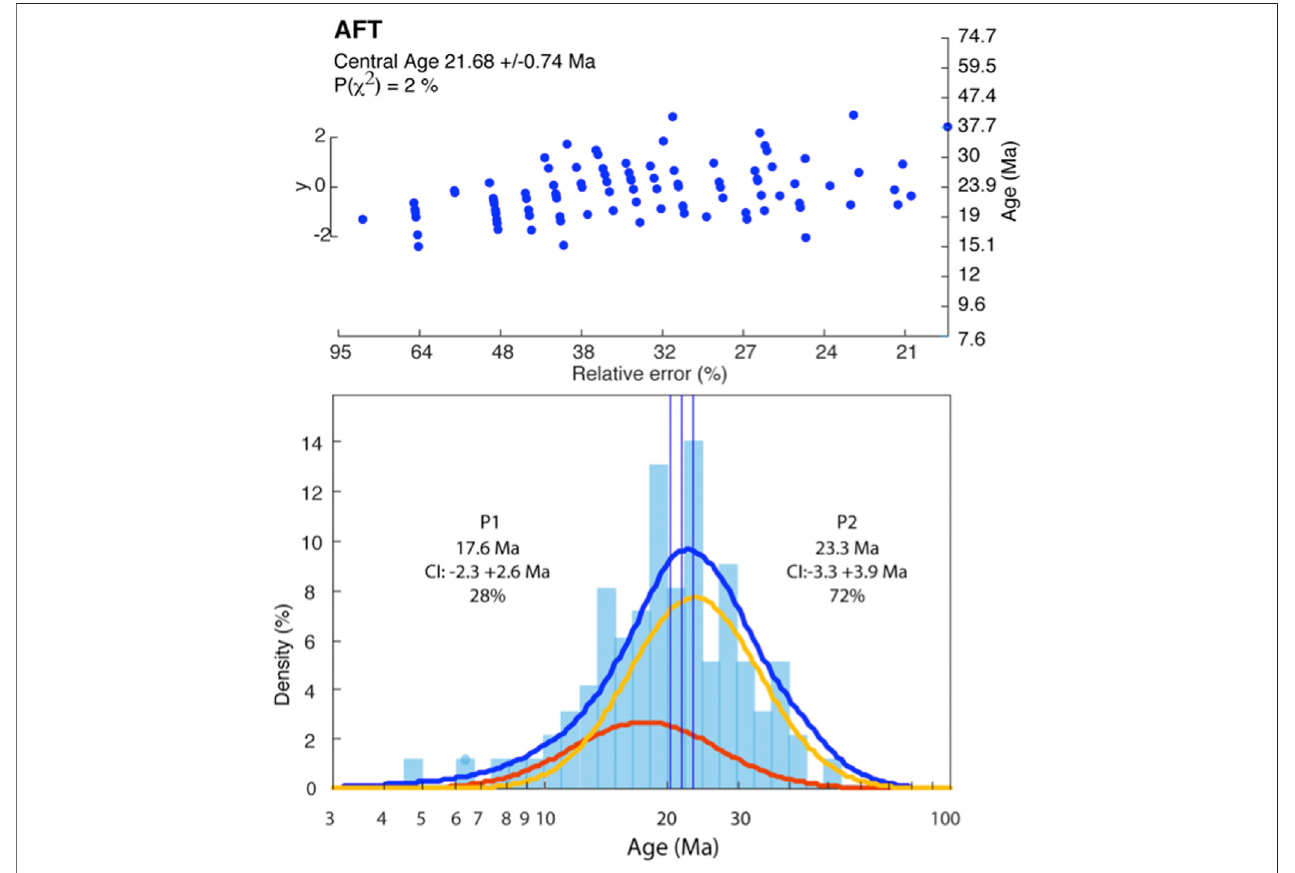
FIGURE7| ApatiteFissionTrackdatingdistributioninthesample.Thecentralageofthewholepopulationis21.68 ± 0.74 Ma,whichcanbedecomposedintotwo age populations (histogram below) using kernel density estimate techniques, showing a major peak (P2, 72%) at 23.3 Ma and a minor one (P1; 28%) at 17.6 Ma.